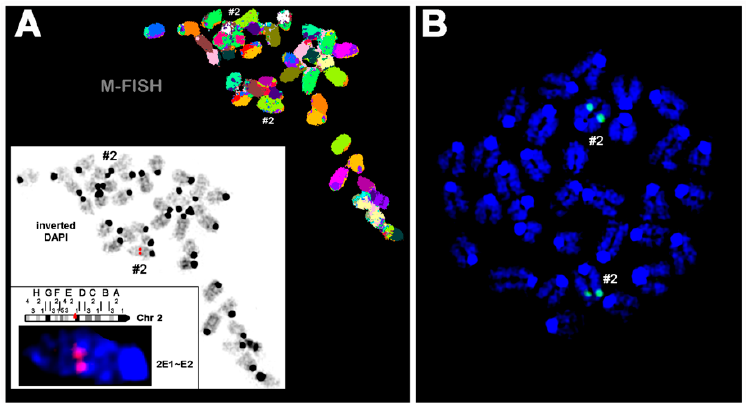
Figure 2. Fluorescence in situ hybridization of mouse chromosomes using the human ALOX15 cDNA as probe. Pro-metaphase chromosomes were prepared as described in Section 4. ( A ) A Metaphase spread prepared from hepatocytes of a heterozygous founder animal is shown after the M-FISH set using all 21 murine whole chromosomes. In the white frame, the inverted 4 ′ ,6-diamidino-2-phenylindole counter-staining of the same metaphase is shown with the signal of the ALOX15 cDNA (red signal) from the first round of FISH (for details see Section 4). Accordingly, the human ALOX15 cDNA was inserted in one of the two murine chromosomes 2 (#2), more exactly into subband 2E1~E2. ( B ) FISH result of a homozygous aP2-ALOX15 individual. These data indicate that the human ALOX15 transgene was inserted in both homologous murine chromosomes 2. Here, chromosomes were counterstained in blue by DAPI.